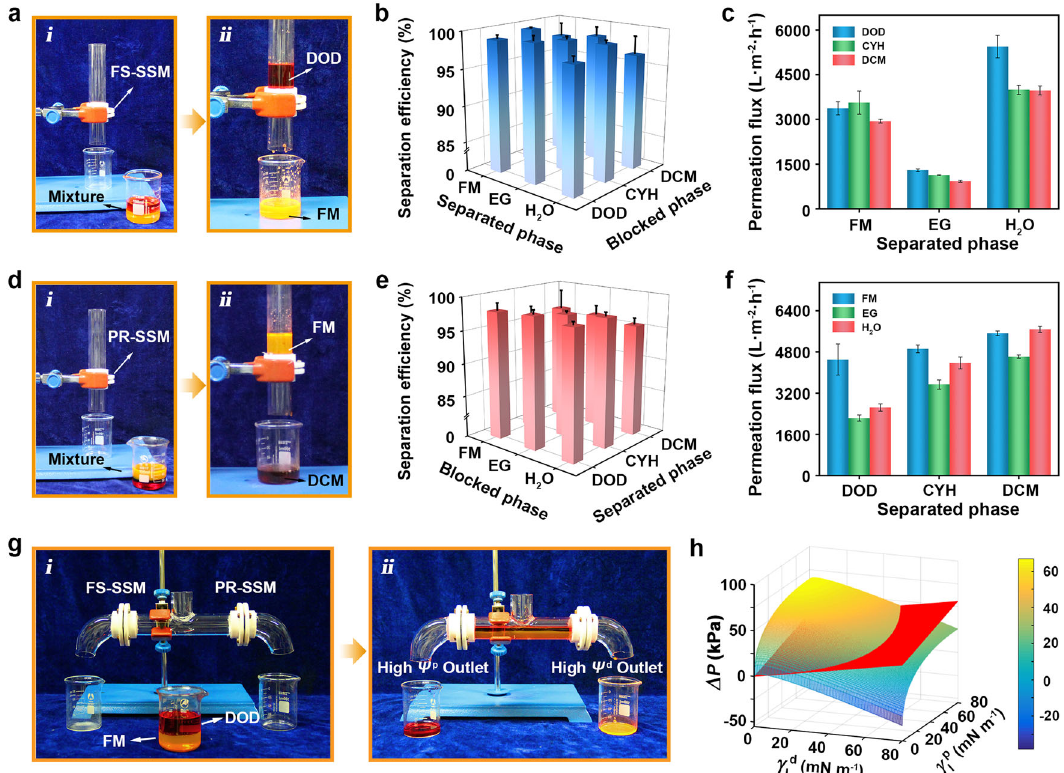
Fig. 4 On-demand OL separation of the membrane system. a Separation process of immiscible FM/DOD mixture that FM passes through FS-SSM but DOD is remained (from i to ii). b Separation ef fi ciencies for different OL pairs of FS-SSM. c The permeation fl ux of the FS-SSM for the above liquid mixtures. d Inverse separation process of the FM/DCM mixture using PR-SSM, in which DCM passes through but FM is remained (from i to ii). e Separation ef fi ciencies and f the corresponding permeation fl ux for different OL pairs of PR-SSM. g Smart separation of FM/DOD mixture through a self- adaptive fl uidic separation device with two outlets. FM (high Ψ p liquid) has a strong permeability to the FS-SSM gate, while the other PR-SSM gate provides passable channels for DOD which is ascribed to its high Ψ d . h Δ P as a function of γ l d and γ l p for impacting the separation of OL mixtures for FS-SSM. The red tilting plane represents critical Laplace pressure ( Δ P c